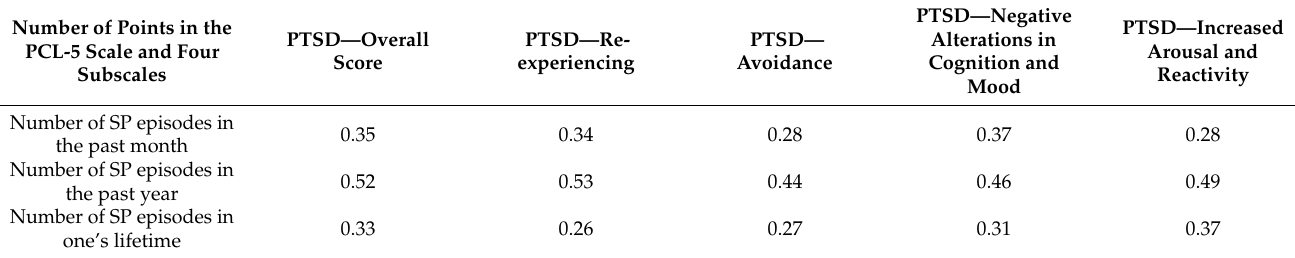
Table 3. Correlation between PTSD symptoms and the number of SP episodes.